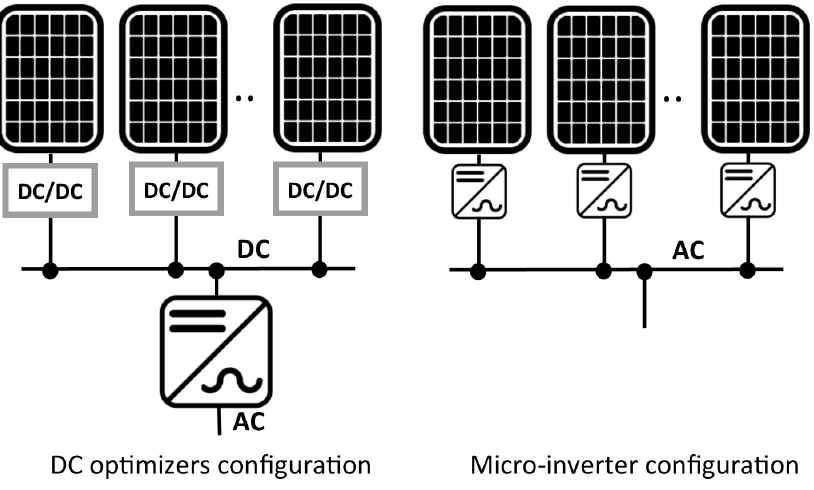
Figure 1. The schematics of DC optimizer configuration ( left ) and microinverter configuration ( right ) for rooftop PV